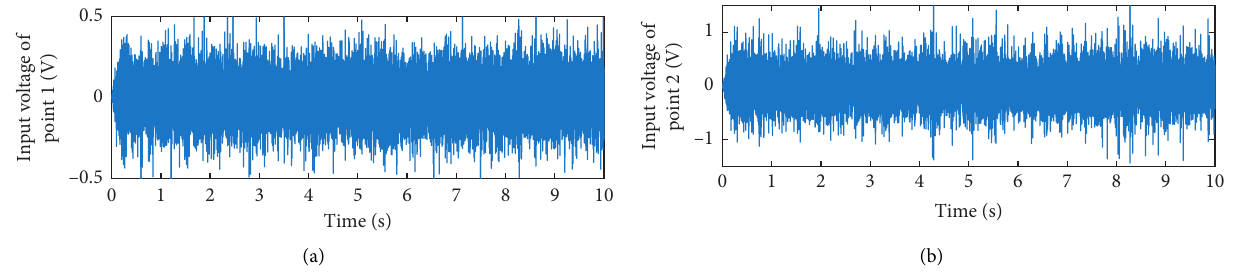
Figure 22: Input voltage signals sent to the vibration table.